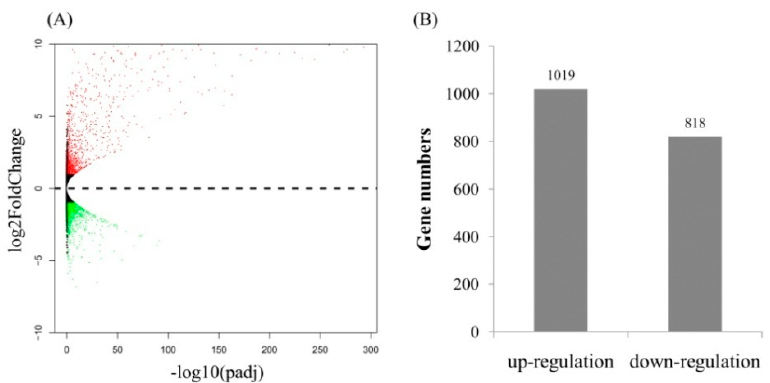
Figure 2. Differentially expressed genes (DEGs) between two samples. ( A ) Volcano plots; ( B ) Number of up-regulated and down-regulated genes.